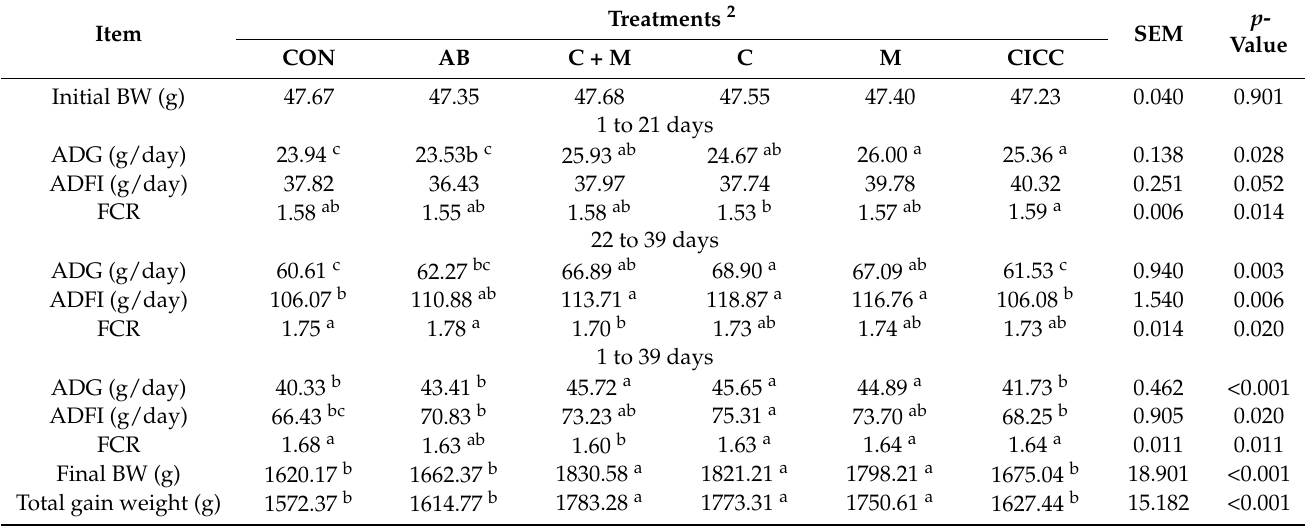
Table 1. Effect of Bacillus amyloliquefaciens LFB112 on growth performance of broilers 1